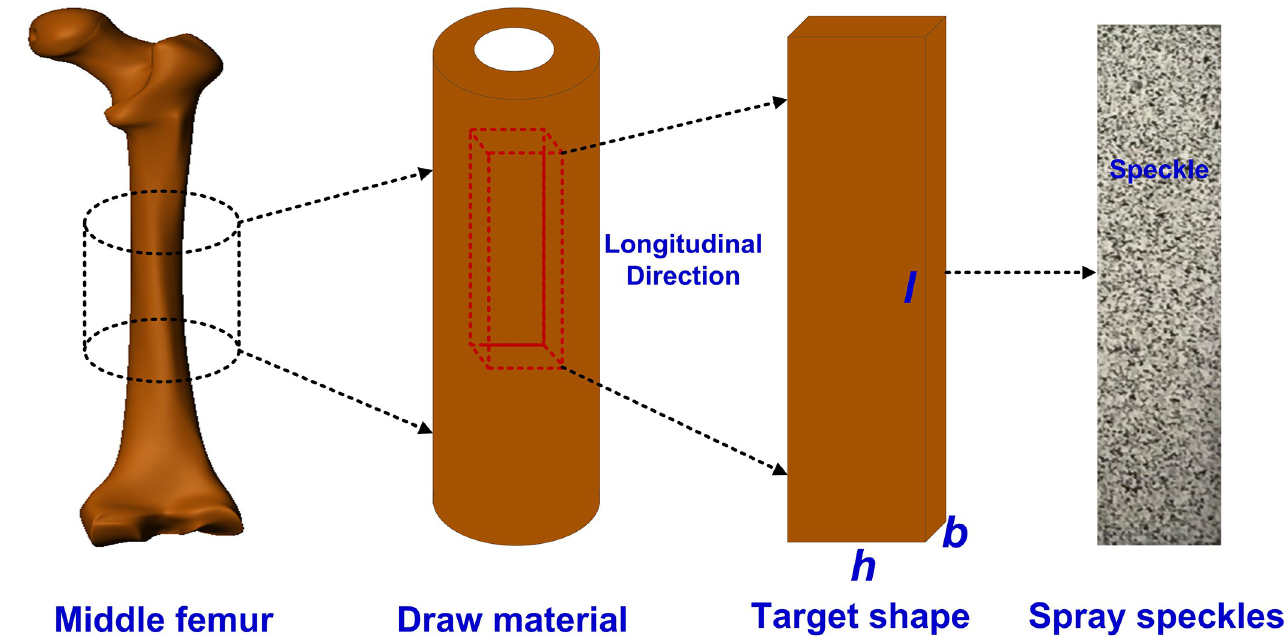
Fig 1. Scheme of obtainment process of cortical bone specimen.